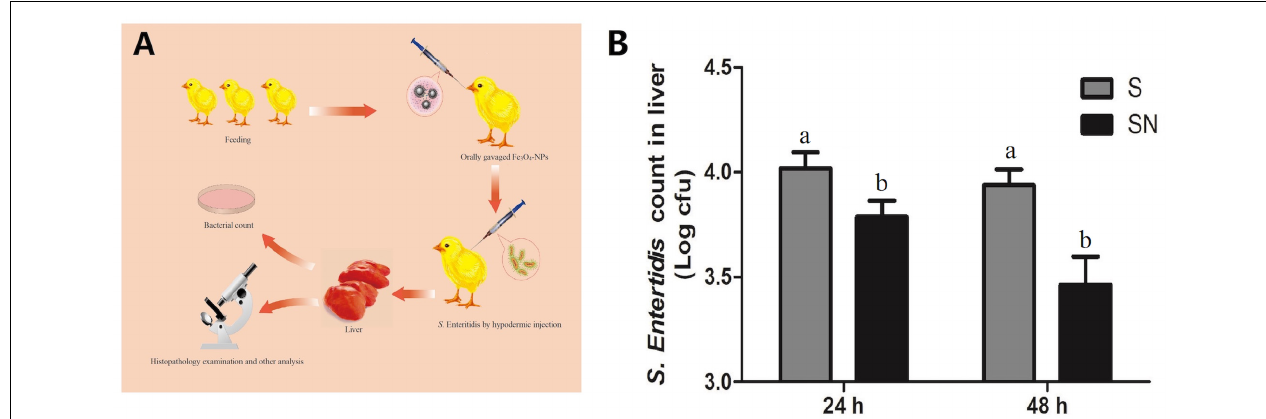
FIGURE 2 | The inhibitory effects of Fe 3 O 4 -NPs on Salmonella enteritidis in chickens. Chickens were treated with control (C), Fe 3 O 4 -NPs alone (N), or infected with S . Enteritidis in the absence (S) or presence (SN) of Fe 3 O 4 -NPs. (A) Schematic illustration of the animal experiment. (B) Bacterial inhibition rates of Fe 3 O 4 -NPs at different times in livers of S . Enteritidis infected chickens. Values represent the mean ± SEM. Different letters indicate statistically significant differences.